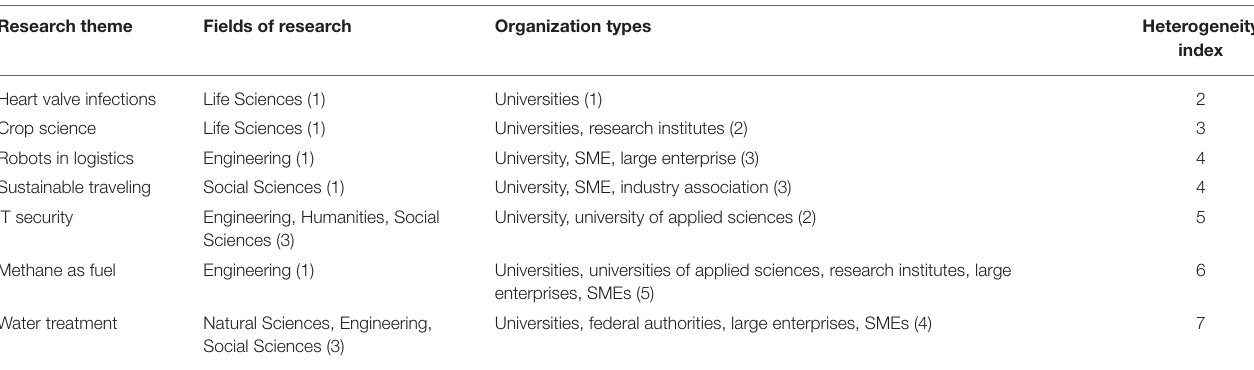
TABLE 3 | Key characteristics of the seven RCs under